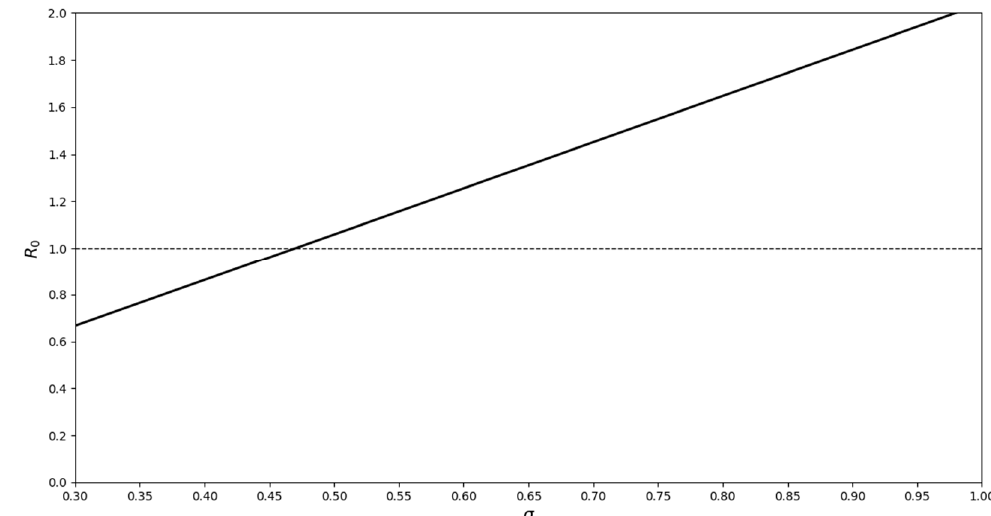
Figure 9. R o values for the introduction of one A H individual into a population of A S = 28 and A U = 1 (M D(U) = M D(H) = 0.775, Ψ = 0.45, M N = 0.2). A S is the number of susceptible individuals, Ψ is the contact rate, σ is the likelihood of transmission, M N is the natural mortality rate, and M D is the mortality rate associated with ranavirosis.